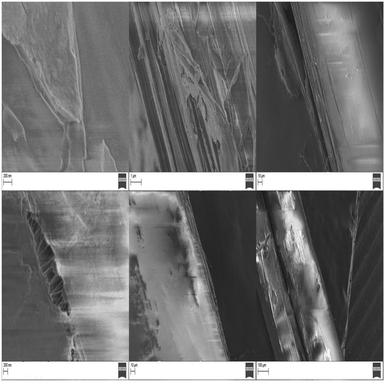
SEM images of the weathered marine rope, probably the polypropylene one, from the La Coruňa pelagial waters.